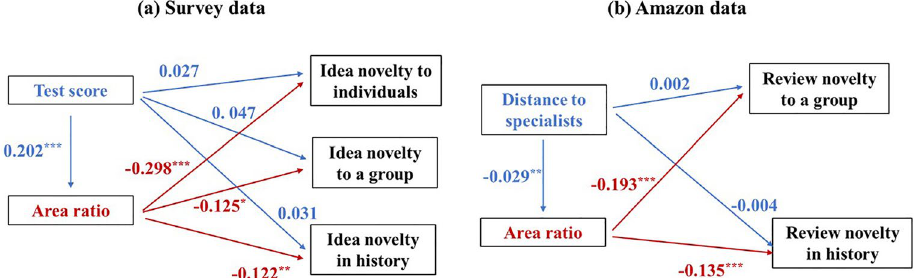
Figure 4. Illustration of the impact of the amount of professional knowledge on creative performance through the attention deployment pattern. The left panel shows the results based on the survey data and the right panel, based on the Amazon data. The rectangles represent the metrics of the amount of professional knowledge (in blue), attention deployment pattern (in red), and creative performance (in black). The blue lines show the impacts of the amount of professional knowledge on other variables (i.e., attention deployment pattern and creative performance). The red lines show the impacts of the attention deployment pattern on other variables (i.e., creative performance). The numbers around the lines represent the coefficient of structural equation models. The asterisks represent the sizes of the p-values ; One asterisk refers to a p -value smaller than 0.1, two asterisks to a p -value smaller than 0.05, and three asterisks to a p -value smaller than 0.01. Parentheses indicate the standard error of each